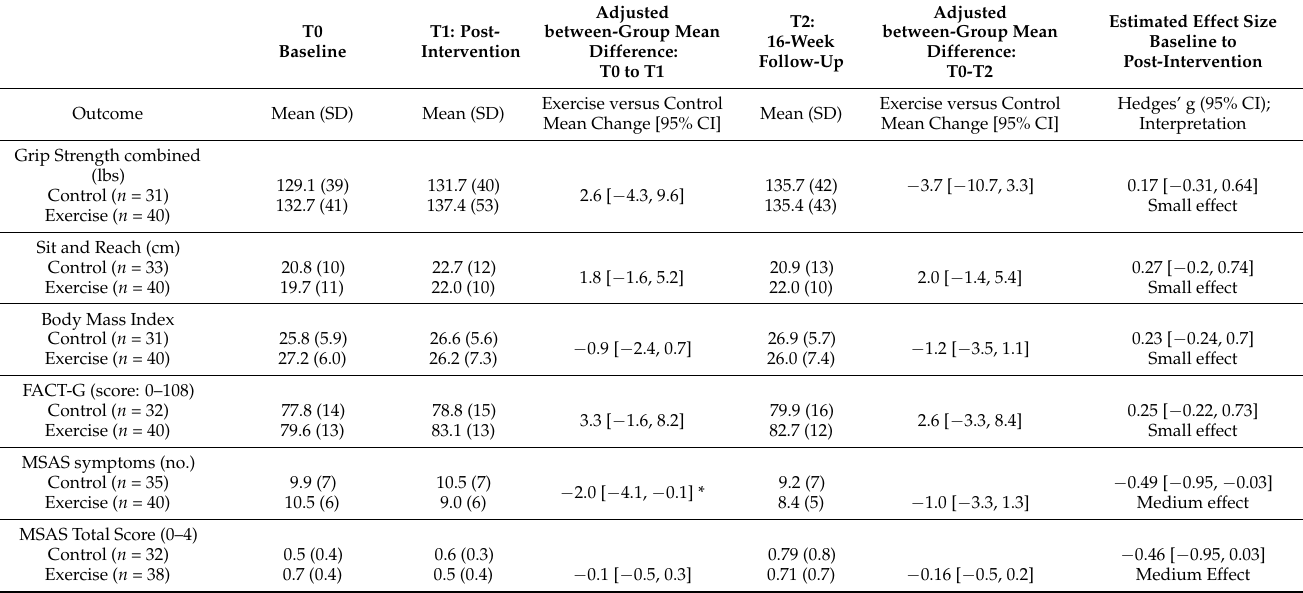
Table 4. Secondary